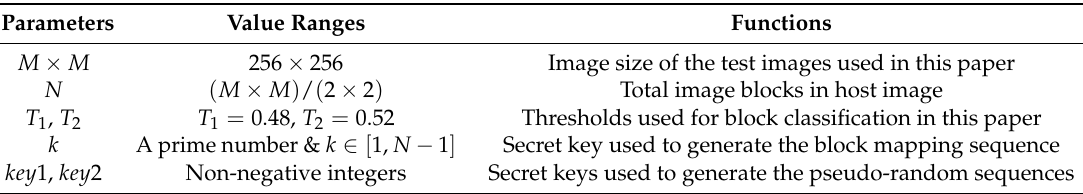
Table 1. Parameters used in watermark generation and embedding processes.